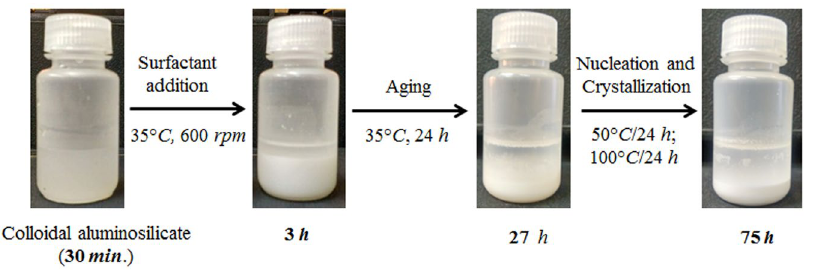
Figure 2. Synthesis mixture (digital photographs) of ZH-Y at various stages of